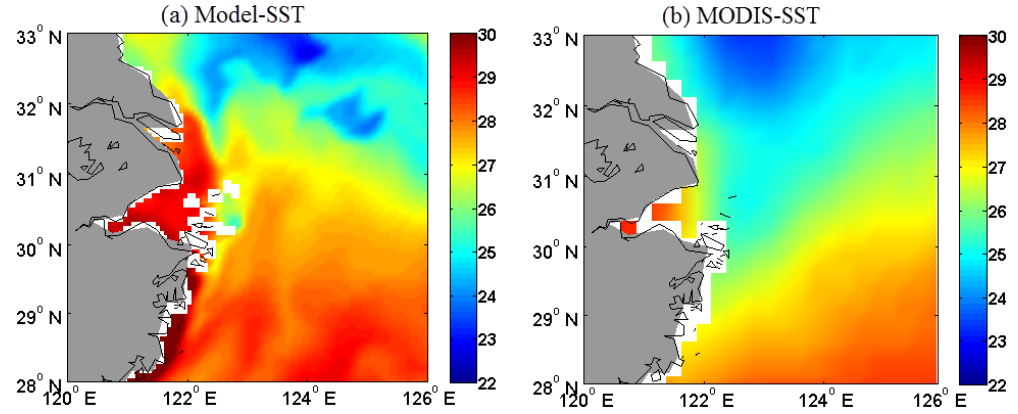
Figure 3. SST distributions in August 2011: (a) model result of SST; (b) remotely sensed SST ( ◦ C;